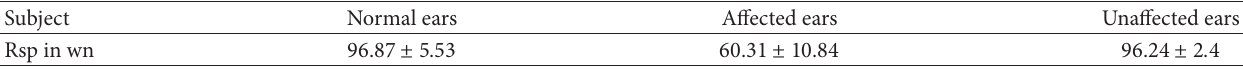
Table 3: The mean of recognition of spoken phonemes in white noise (Rsp in wn) in the patient and the normal groups. Subject